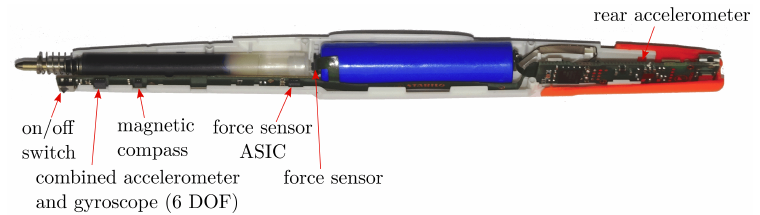
Figure 2. Sensor distribution in the